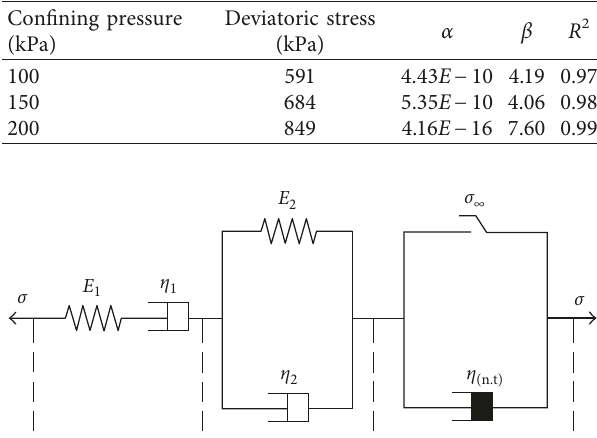
Table 5: The parameters of the damage constitutive model.